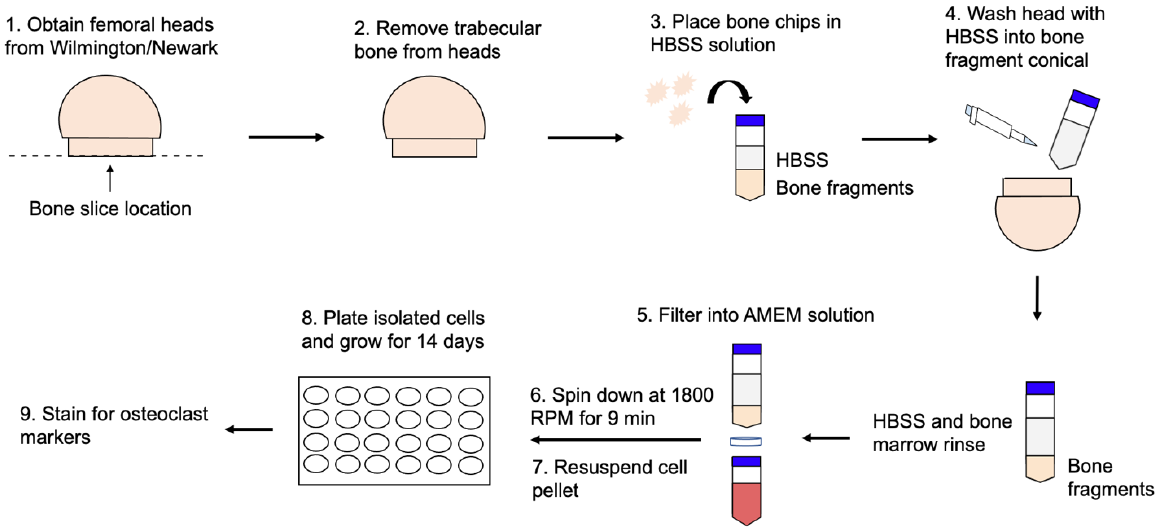
Figure 2. Femoral heads from patients diagnosed with OA or OP were obtained from ChristianaCare in Newark, DE or Wilmington, DE. The trabecular bone was removed from the heads and placed in α -MEM. The interior surface of the bone was washed with HBSS. Afte r, the α -MEM and HBSS solutions were filtered with a 70 µm filter. The solution was spun down at 1800 RPM for 9 min at 4 °C to form a cell pellet. The pellet was resuspended in 5 mL of α -MEM and cells were plated at a density of 1 × 10 5 cells/mL supplement ed with α -MEM and 25 ng/mL M-CSF. Cells were grown and subjected to experimentation.